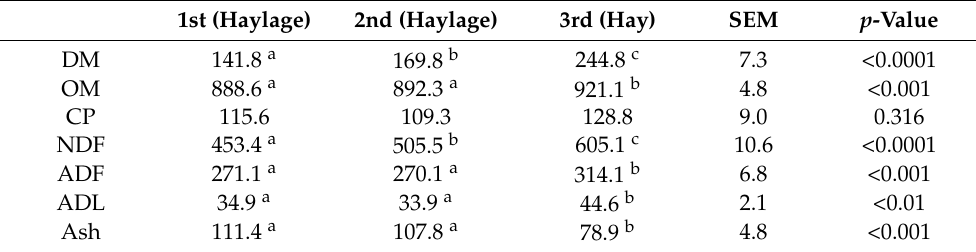
Table 2. Dry matter (DM) content (g/kg) and chemical composition (g/kg DM) of forage before cutting. All values are presented as least square